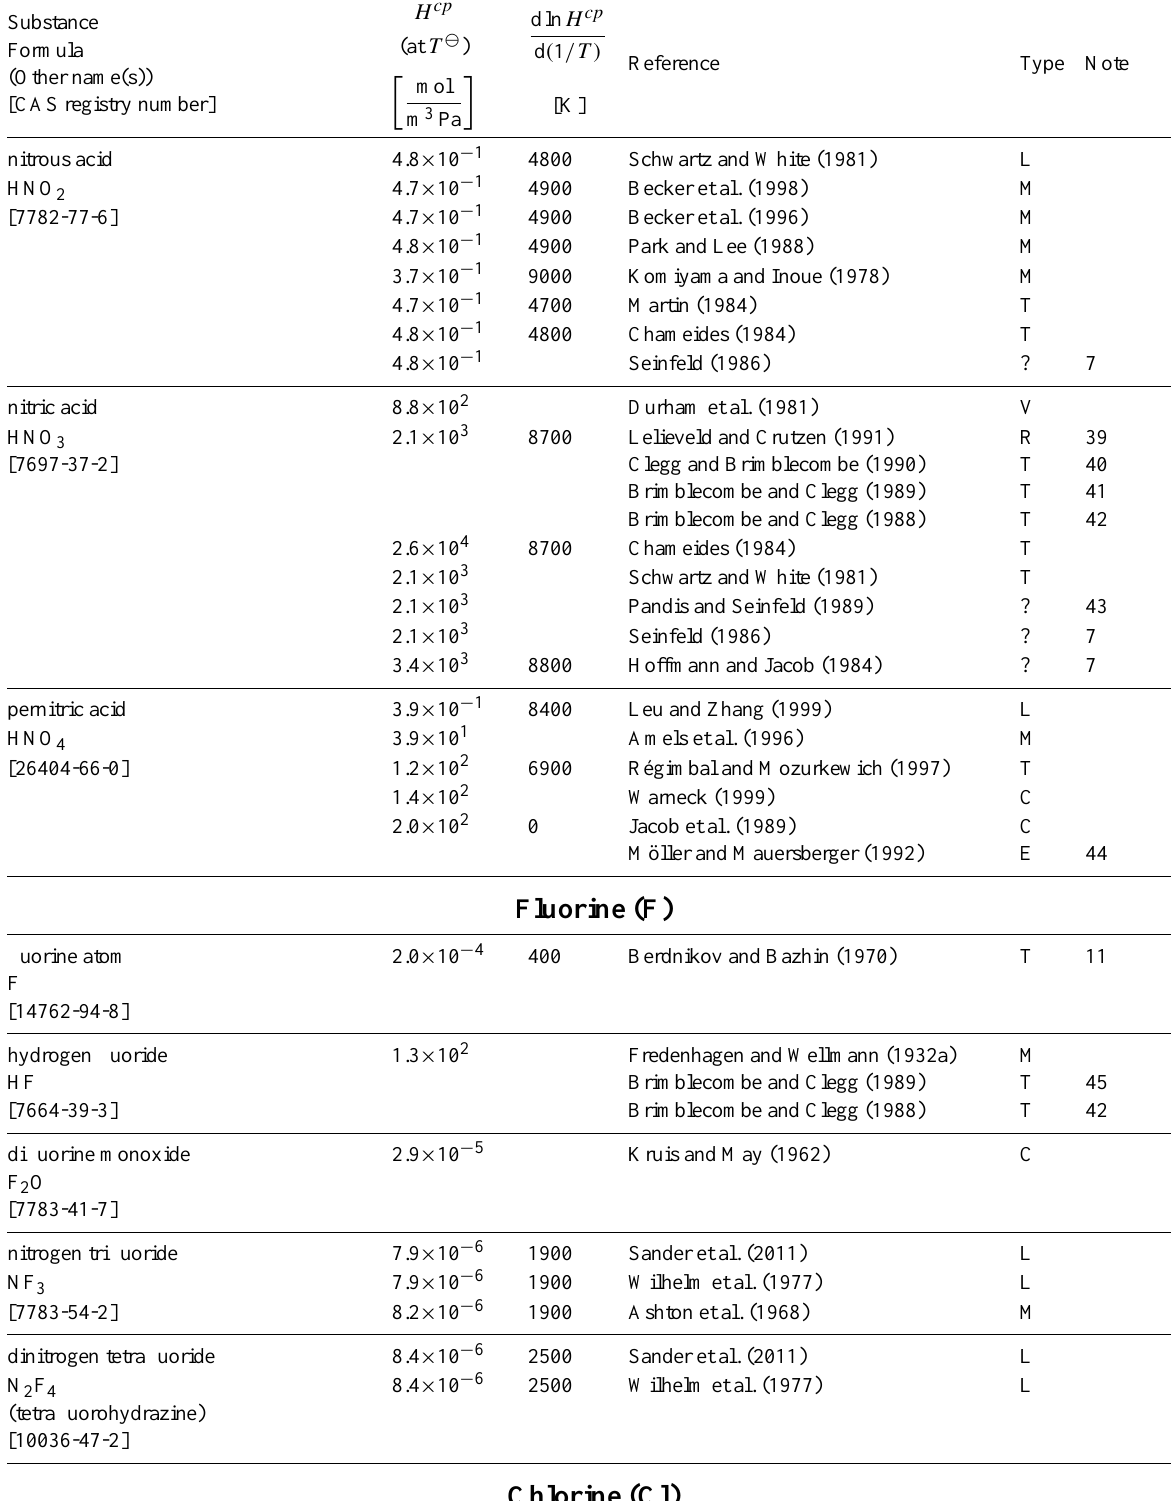
Table 6: Henry’s law constants for water as solvent